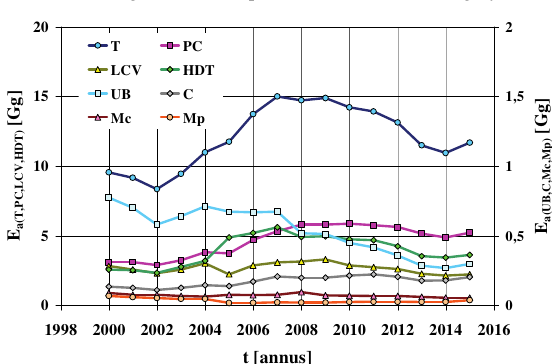
Fig. 15. National annual emission of particulate matter PM2.5 from tribological elements per cumulated vehicle category